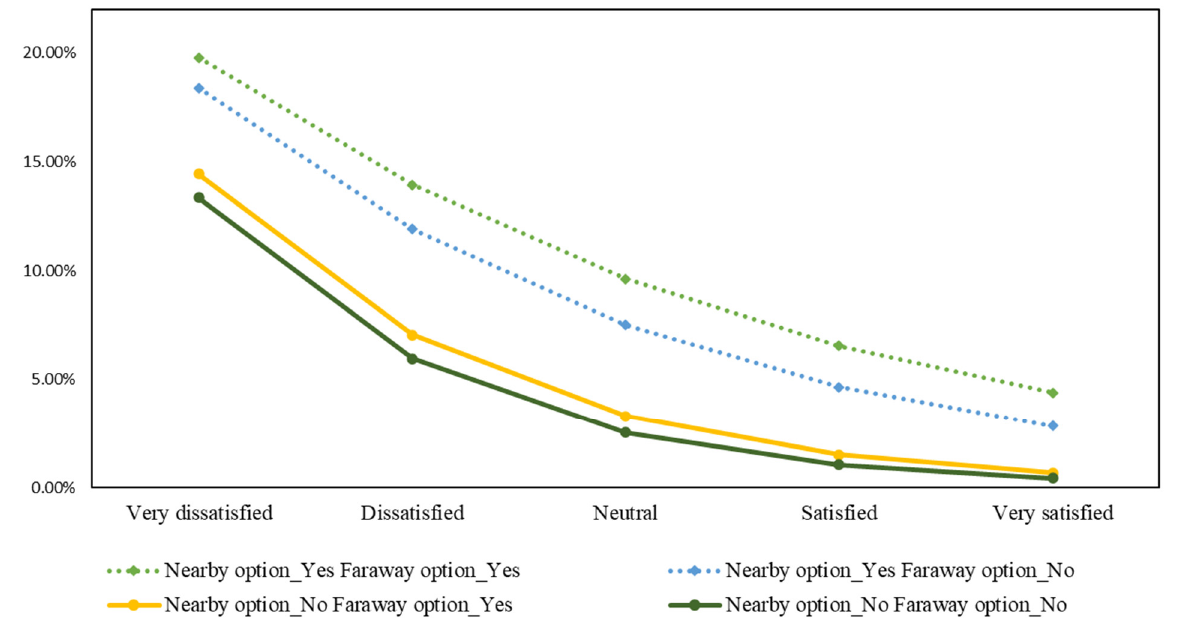
Figure 10. Probabilities of migration intention in male citizens, aged 31–40, college level, based on air quality satisfaction, perceived availability of nearby and faraway migration alternatives.